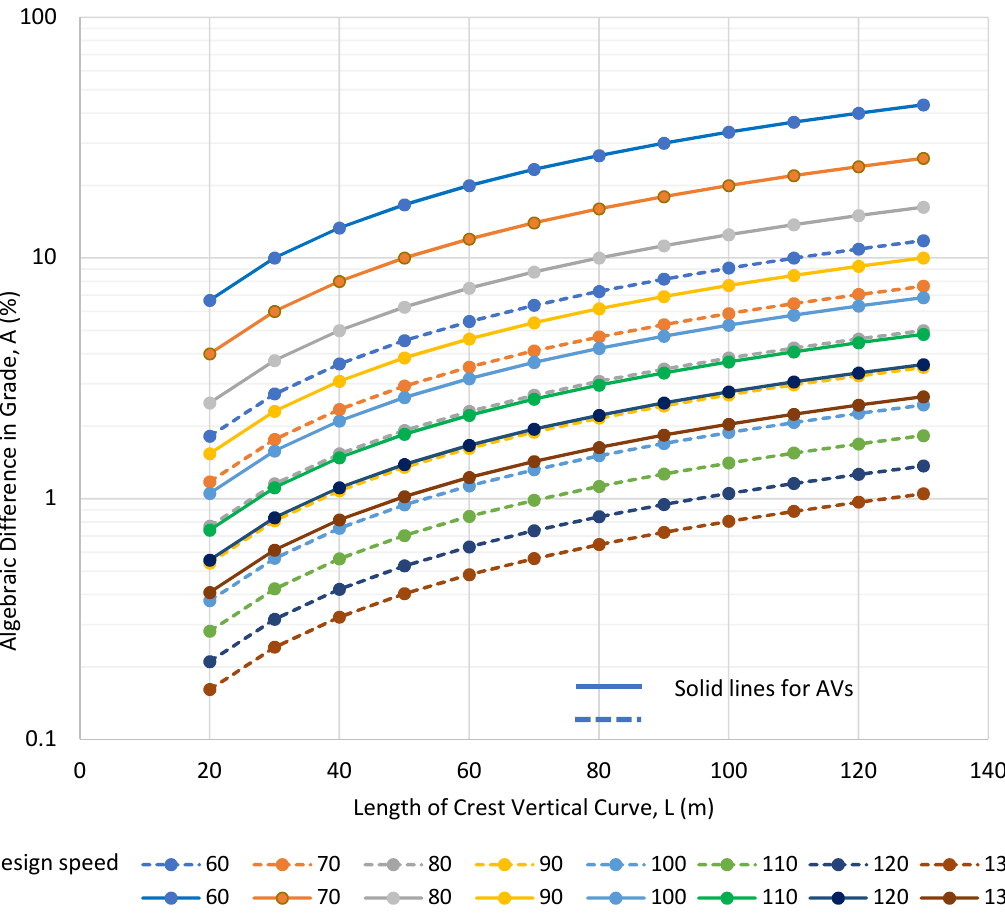
Figure 7. Design Control for Crest Vertical Curves for the case of human-driven vehicles and AVs.